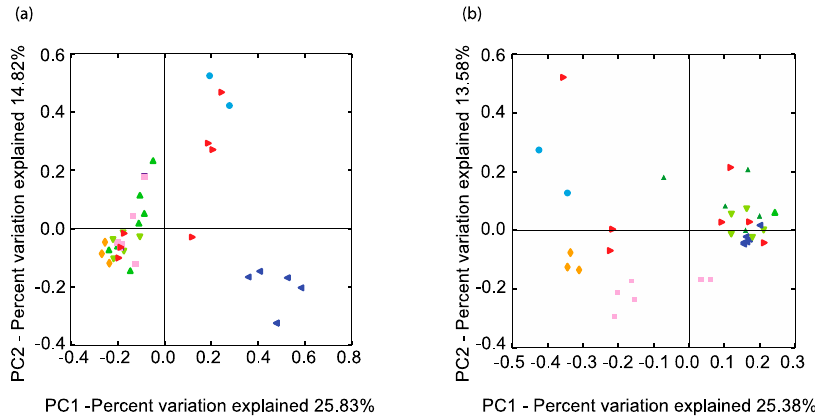
Figure 3. Comparison of the phylogenetic distances of the ( a ) SRM and ( b ) methanogen related communities in the BCRs and other features. Only the two axes of the three-dimensional principal component analysis are shown explaining the most variation. Same colour legend as Figure 1.